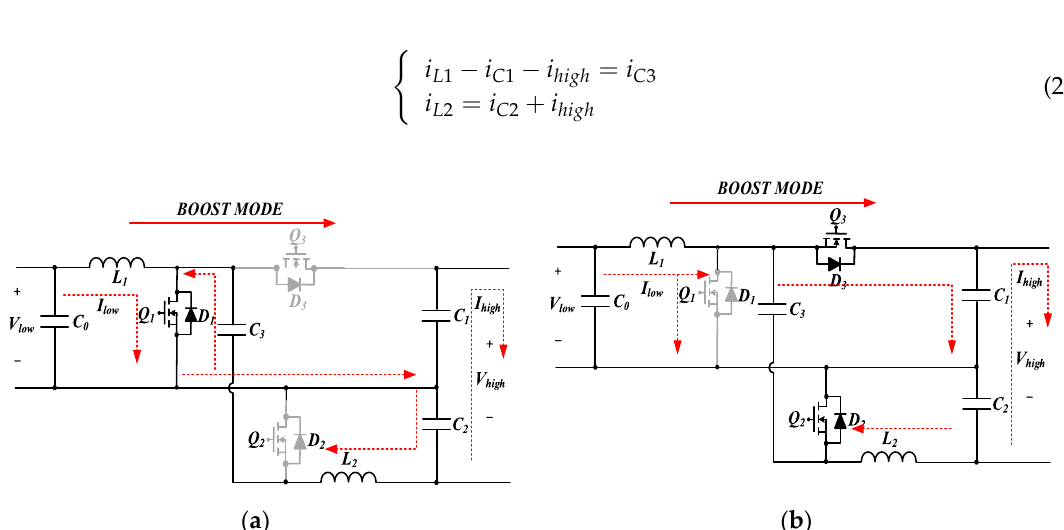
Figure 7. Topological states of converter II in boost mode. ( a ) [ t 0 –t 1 ]. ( b ) [ t 1 –t 2 ].